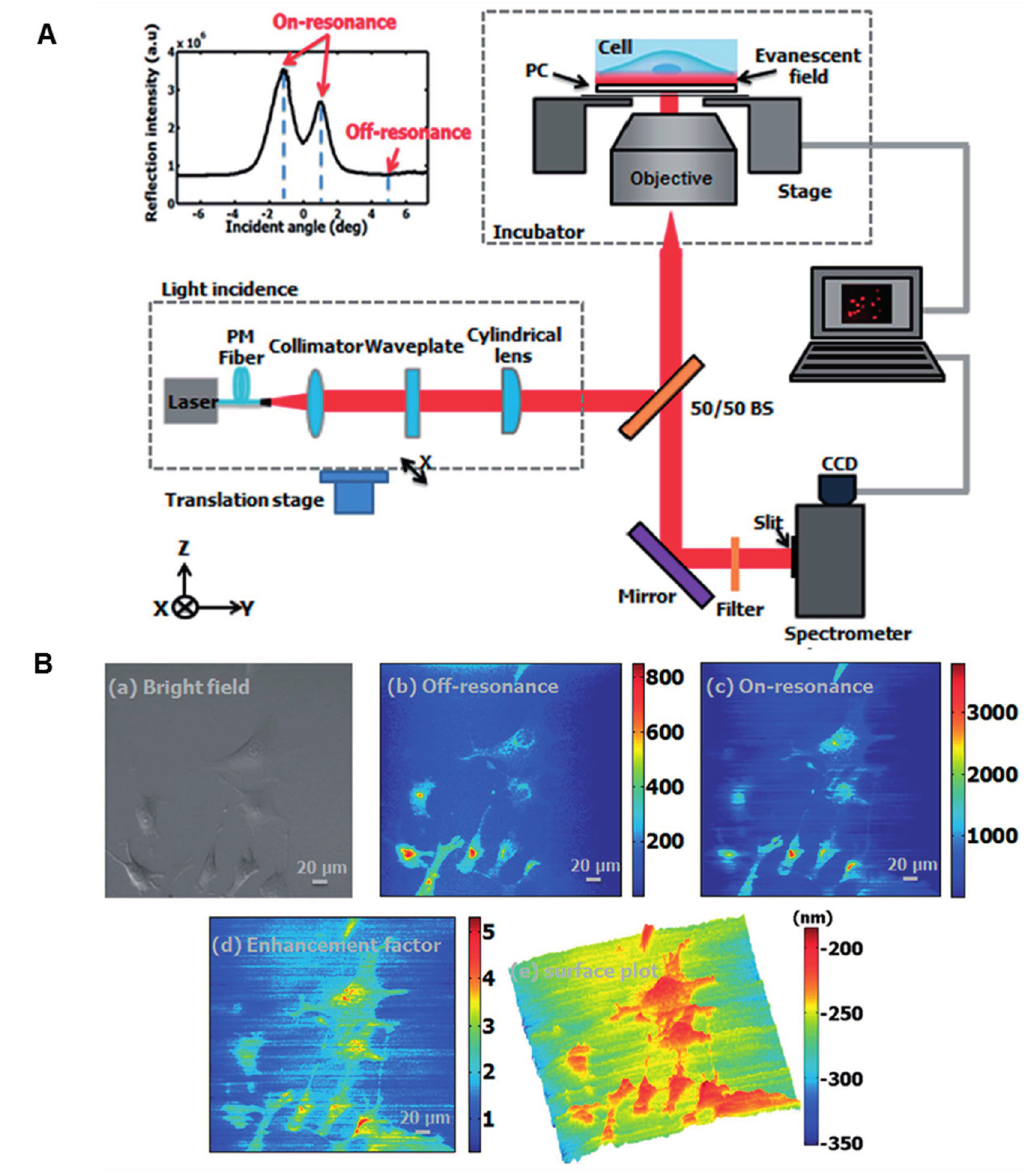
Figure 7. Photonic Crystal Enhanced Fluorescence (PCEF) portion on a PCEM imaging system. ( A ) Schematic of the PCEF portion on modern PCEM detection instrumentation. Inset (top left): angle reflection spectrum; ( B ) Brightfield and PCEF images of membrane dye-stained 3T3 fibroblast cells: (a) brightfield, (b) off-resonance PCEF, (c) on-resonance PCEF, (d) enhancement factor image, (e) 3D surface plot image of the enhancement factor (Reprinted in part with permission from [96], © 2014 RSC